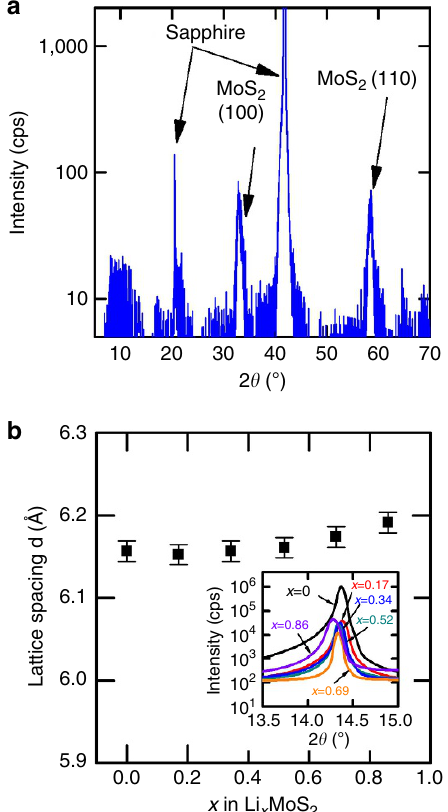
Figure 5 | X-ray diffraction characterization of Li x MoS 2 samples. ( a ) X-ray diffraction spectra for MoS 2 thin-film samples on sapphire substrate. The two diffraction peaks coincide with the standard X-ray diffraction powder patterns of MoS 2 (100) and (110). Therefore, the dominant lattice orientation in the MoS 2 thin-film samples are (100) and (110). The diffraction peak at 32.8 (cid:2) and 58.5 (cid:2) corresponds to a lattice constant of 2.73 and 1.58Å, respectively. ( b ) Lattice spacing d between MoS 2 layers in bulk MoS 2 samples. The error bars are calculated by taking into account the experimental errors and the systematic errors that propagate from uncertainties in the fitting of X-ray diffraction spectra. The inset plot is the change of MoS 2 (002) peak position with x in Li x MoS 2 for pristine MoS 2 and Li 0.86 MoS 2 , respectively, a 0.5% change in lattice constant. We estimate the uncertainty of the lattice spacing measurement as E 0.6%. The weak dependence of lattice constant on lithium content is consistent with the fact the effective ionic radius of lithium ion 25 (76 pm) is slightly smaller than the octahedral site in the van der Waals gap of in MoS 2 . If we assume an effective ionic radius of S 2 (cid:2) as 1.84 Å, and close packing of S 2 (cid:2) atoms, the radius of the octahedral site is 76 pm (ref. 25). Our measurement on the layer spacing of Li 0.86 MoS 2 agrees with recent observations reporting on minimal change in interlayer distance of LiMoS 2 (refs 26,27).